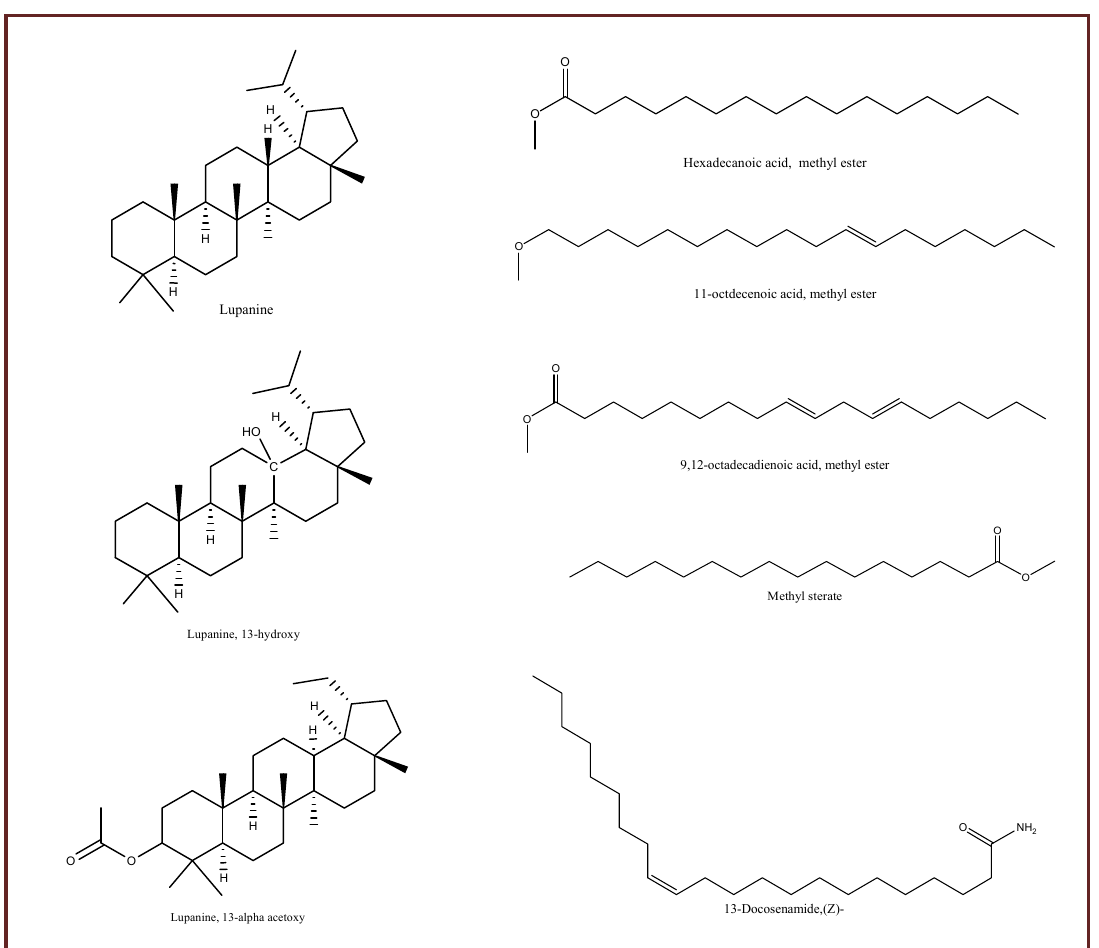
Figure 2. Major bioactive compounds present in nine cultivars of lupin species in both unprocessed and processed